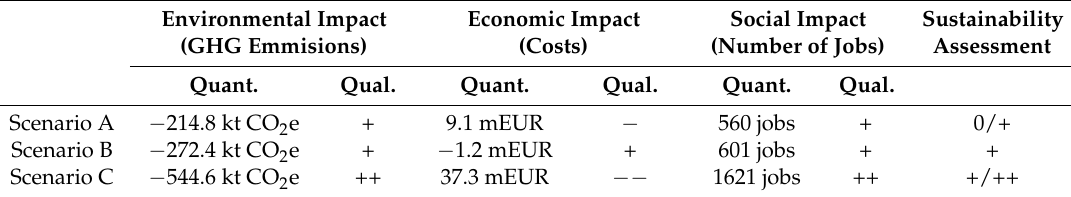
Table 2. Summary of quantitative findings and qualitative